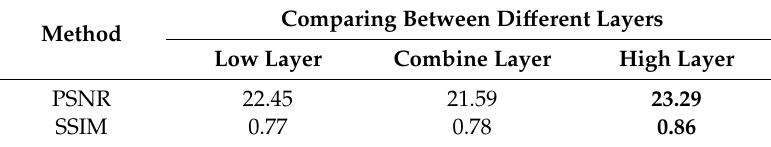
Table 6. PSNR and SSIM of di ff erent layer on Kohler dataset.